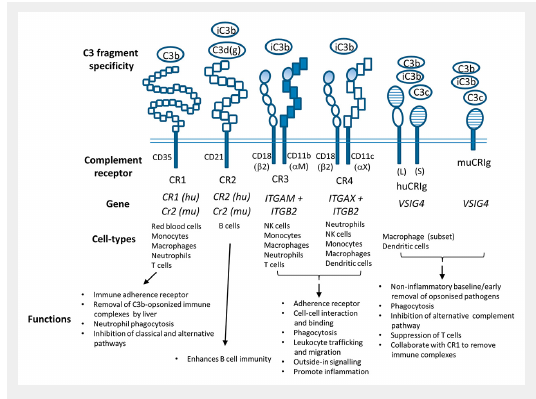
Characteristics, function and expression of complement receptors The structural domains of the five known types of complement receptors are depicted, together with their specificity of C3 fragments, the genes encoding them, their distribution amongst the different leucocyte types and their known functions. CR1, CR2 and CRIg are single transmembrane proteins with extracellular portions, transmembrane domains and cytoplasmic tails whereas CR3 and CR4 are transmembrane heterodimers of a common β2 integrin (CD18) chain and an α integrin chain, αM (CD11b) or αX (CD11c). Murine CR1 and CR2 are derived from the same gene by alternative splicing whereas the human counterparts are encoded by 2 different genes. CR1 contains thirty short consensus repeats